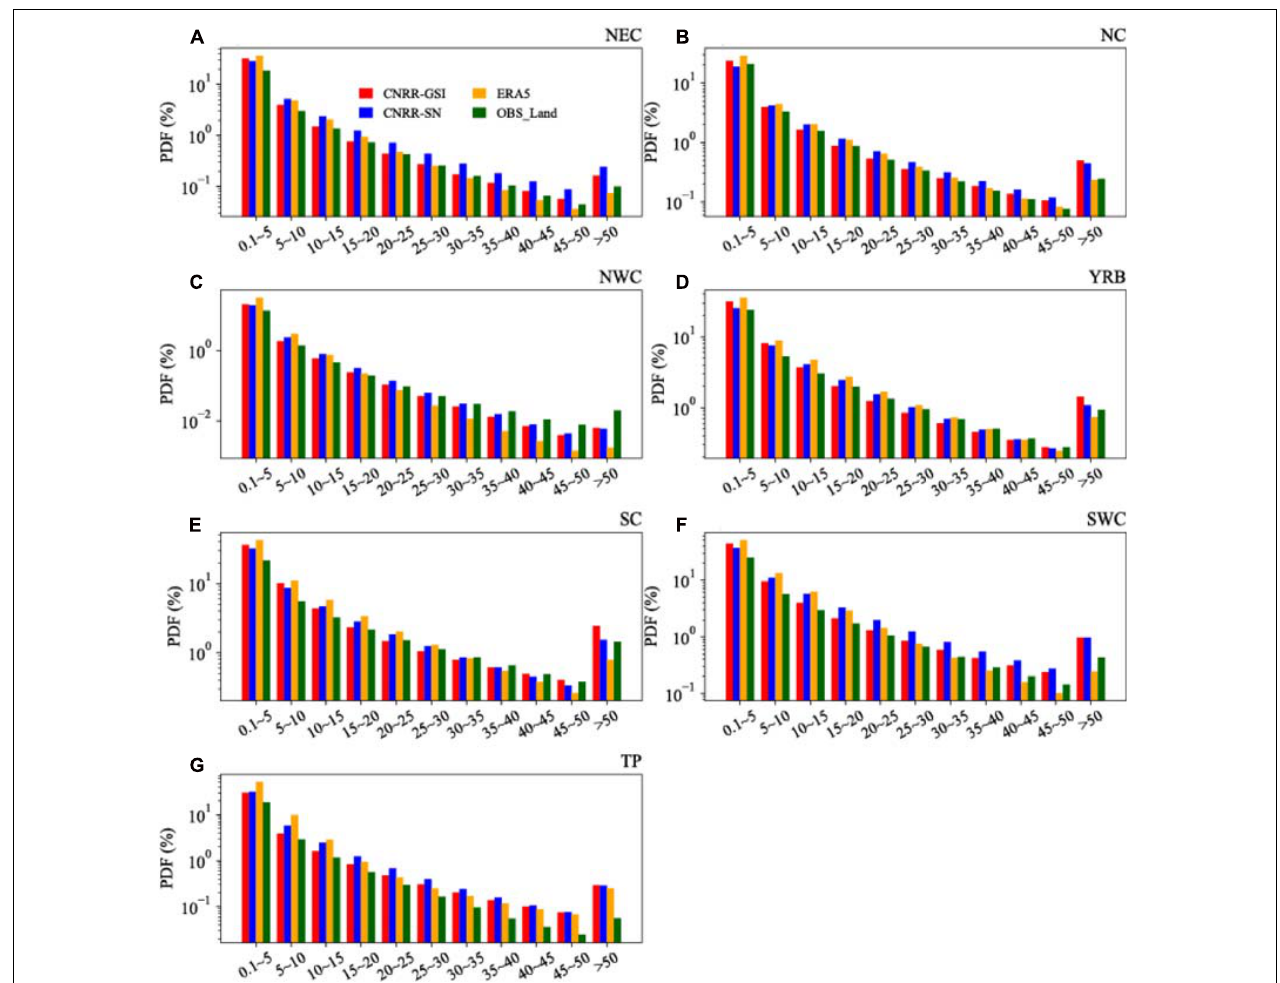
FIGURE 6 | PDFs of the daily precipitation over different sub-domains over